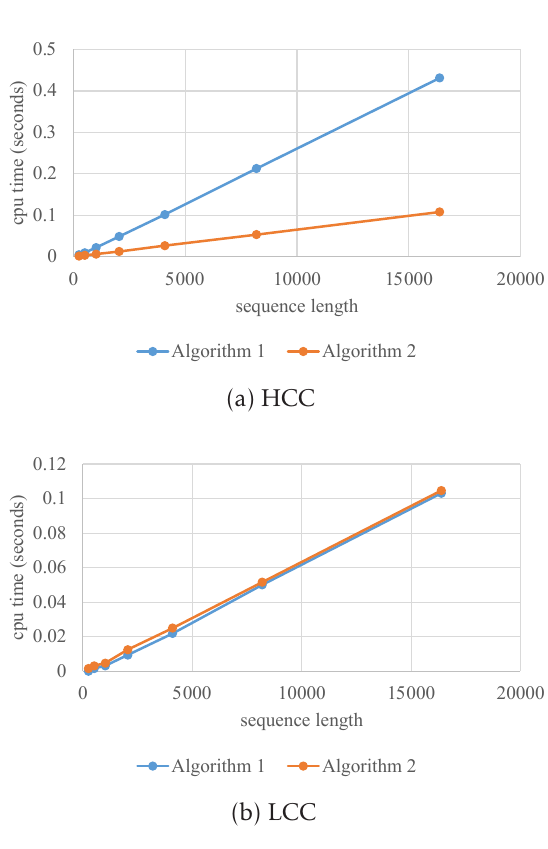
Figure 7. Average CPU time for sequences of 2048 character long String objects.